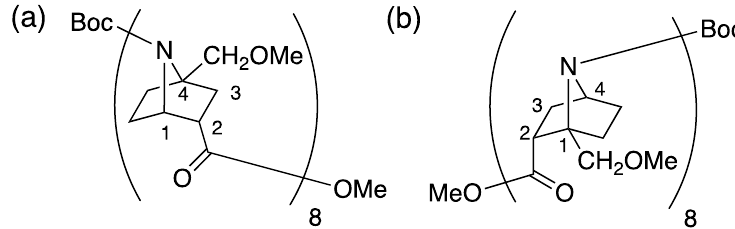
Figure 4. ( a ) Schematic representation of 7-azabicyclo[2.2.1]heptane amide cis -( S )-8mer. ( b ) Schematic representation of the trans -( R )-8mer.